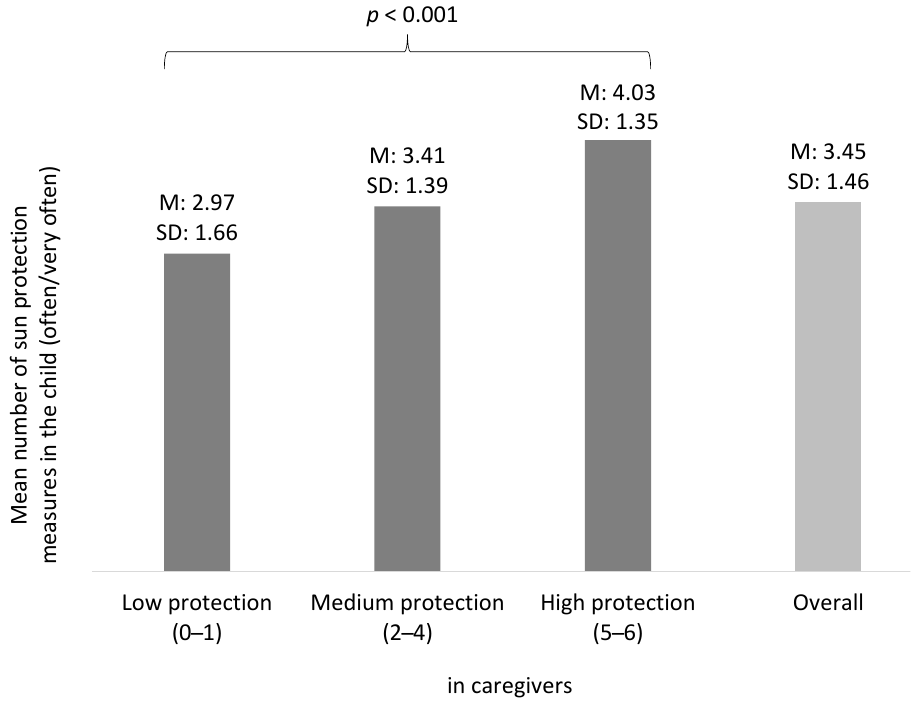
Figure 2. Mean number of sun protection measures used in the child according to caregivers’ protection status. p -value based on Kruskal-Wallis-test; M: Mean; SD: Standard deviation; reported is the mean value of children’s sun protection measures by sun protection measures in caregivers (low vs. medium vs. high protection) Mean of measures used by the caregivers: 2.99 (SD: 1.47).